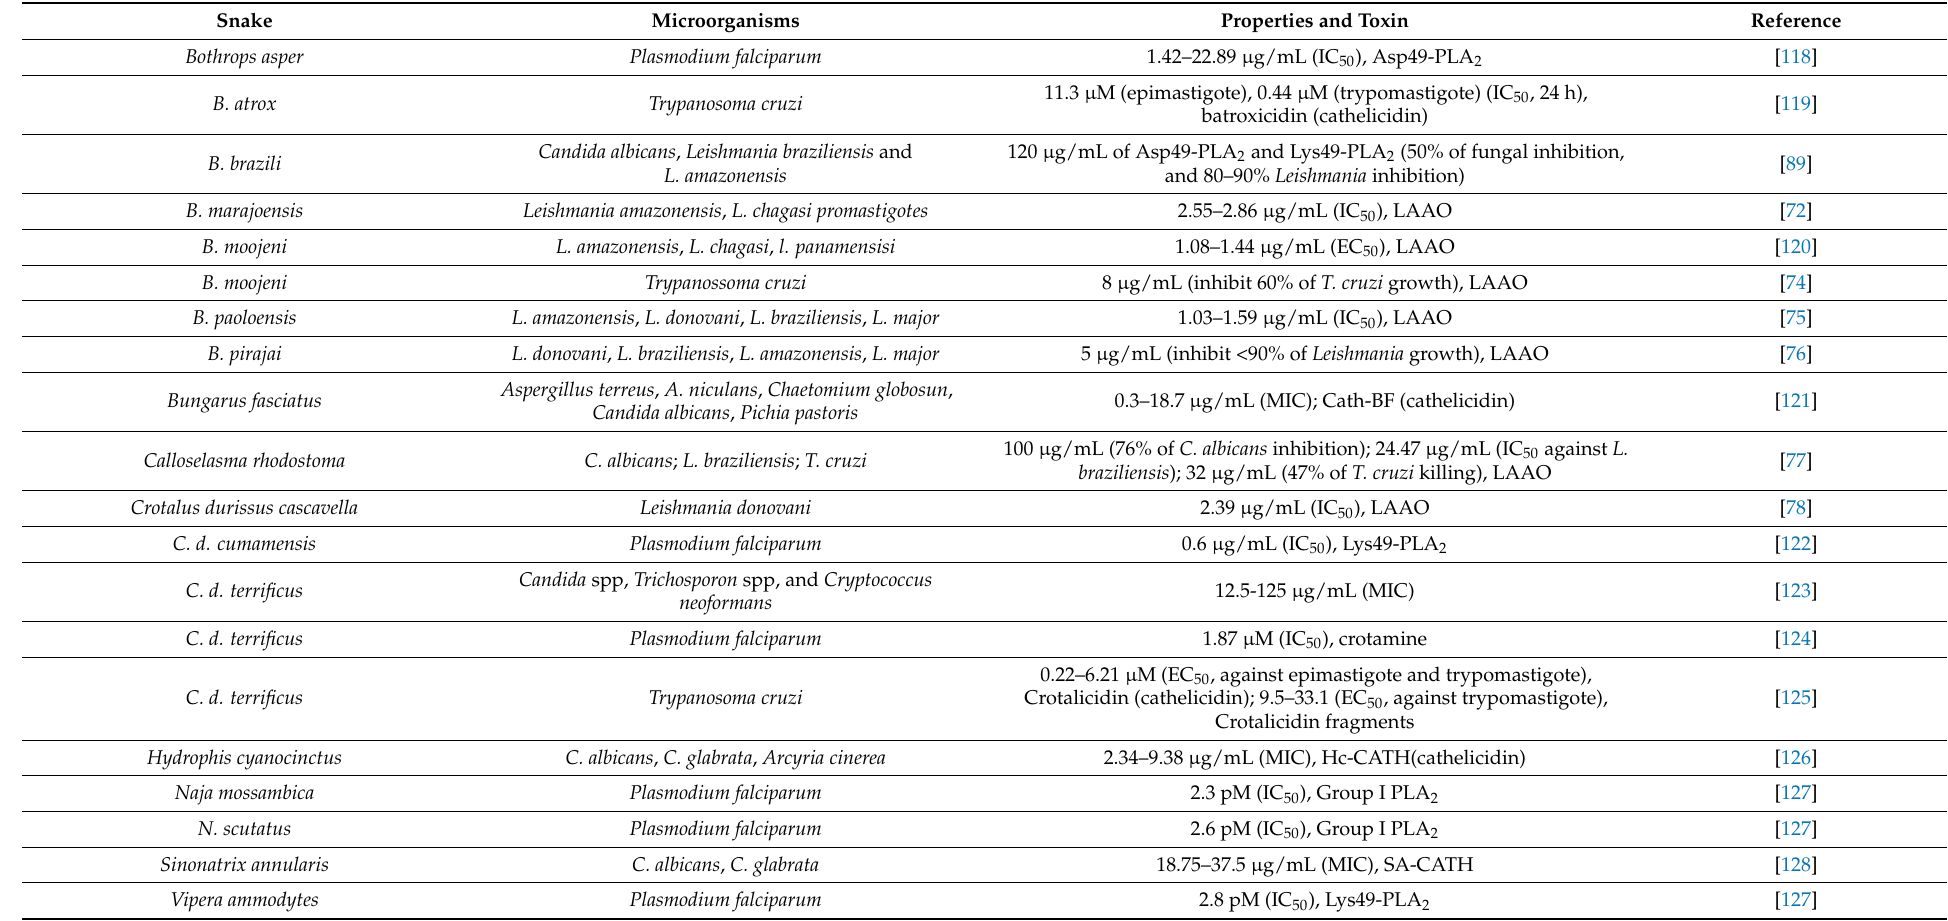
Table 4. Snake toxins activity against fungi and